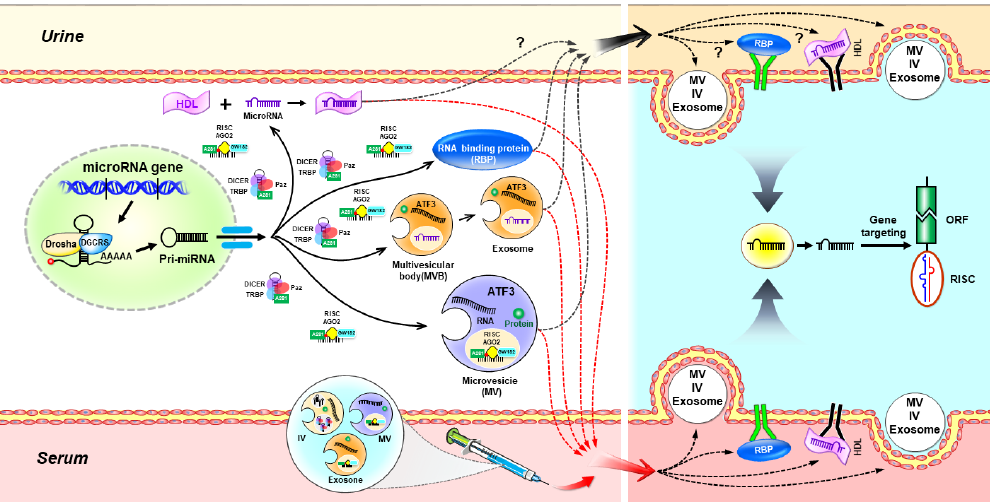
Figure 1. The possible model of intracellular and extracellular miRNAs after acute kidney injury in renal tubular cells. To respond to the acute injury, miRNAs are first transcribed as primary miRNAs (Pri-miRNAs) in renal tubular cells. Next, pri-miRNAs further cleave to the pre-miRNAs by the Drosha/DGCR8 microprocessor complex and then exported into the cytoplasm. In the cytoplasm, pre-miRNAs are then unwound by Dicer to the formation of double-stranded miRNAs which complex with argonaute (AGO) proteins. The mature miRNA guide strand is stably loaded into the RNA-induced silencing complex (RISC) along with AGO2 protein and GW182 to form mature RISC (miRISC) complex, while the other strand is thought to be degraded. The mature miRNAs in the miRISC can base pair with its target mRNAs and lead to the repression of protein translation or mRNA degradation. If the miRISC does not combine with its target strands, miRNAs can then be selected and sorted into the microvesicles (MVs), intermediate vesicles (IVs), or multivesicular bodies (MVBs). Exosomes are then secreted after translocation of MVBs from the cytoplasm to the plasma membrane by exocytosis. miRNAs could also secrete with the collaboration of high-density lipoprotein (HDL), AGO2, or other RNA-binding protein (RBP). Red arrows indicate the possible transport pathways of serum miRNAs (also named “circulating microRNAs”). Black arrows indicate the possible transport pathways of urinary miRNAs. Although most of these in urine remains unknown, the growing emergent data suggested urinary miRNAs could be novel biomarkers for acute kidney injury (AKI). Once miRNAs enter to the downstream target renal tubular cells, and then, again, form miRISC to base pair with its target mRNAs leading to mRNA silencing. Of note, the injection of miRNA targeted therapy, or stem-cell-derived miRNAs might be an innovative therapeutic strategy for AKI. ORF: open reading